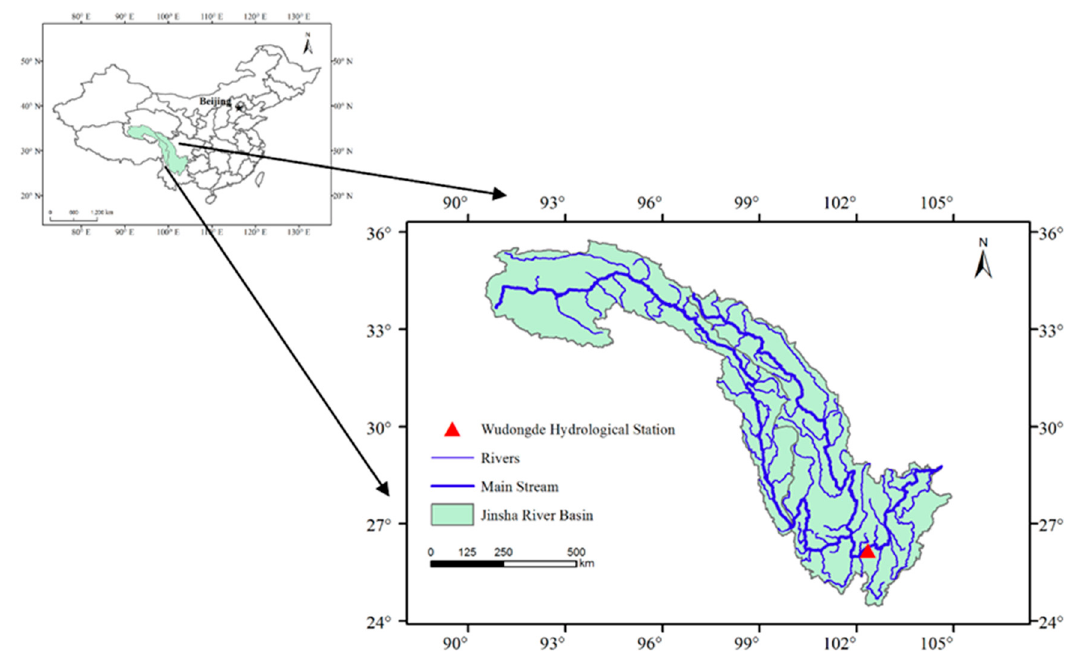
Figure 3. Locations of the Jinsha River basin and the Wudongde hydrological station.